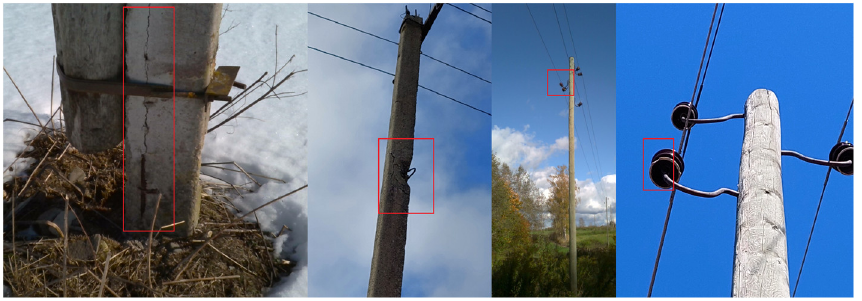
Figure 19. Example of infrastructure visual defects.